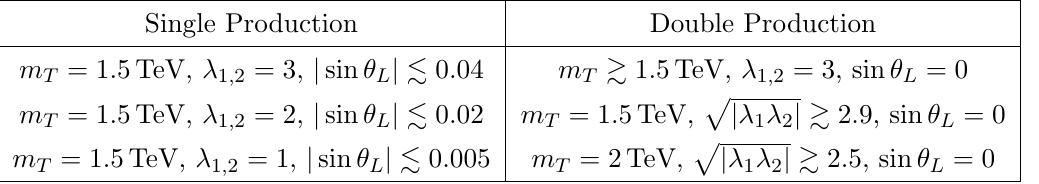
Table 1 . Parameter regions for which Tt production in the dominant single production mode (left column) and Tt production is greater than TT pair production (right column) with scalar mass m S = 200 GeV.